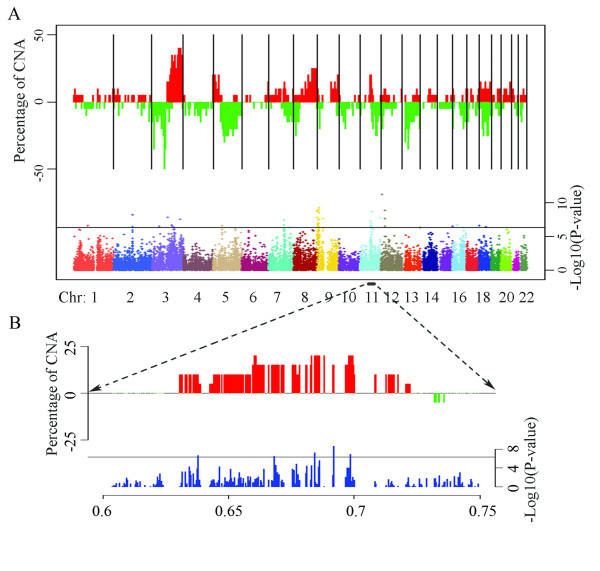
Summary of genome-wide DNA copy number aberrations and concordant gene expression changes. A. Top panel: Percentage of genome DNA amplification (red) and deletion (green) of the 20 OSCC on the human autosomes. Only CNAs with tumor-normal DNA copy number ratio less than 0.7 or greater than 1.4 are counted as deleted or amplified, respectively. Bottom-panel: Manhattan plot of the negative base-10 log-transformed p-value for the correlation coefficients between DNA copy number and gene expression for all the studied genes at each loci. Line indicates the Bonferroni p-value cutoff = -log10(0.01/23,466) = 6.37; B. A close-up view of the 11q13.2-q13.3 high correlation region.